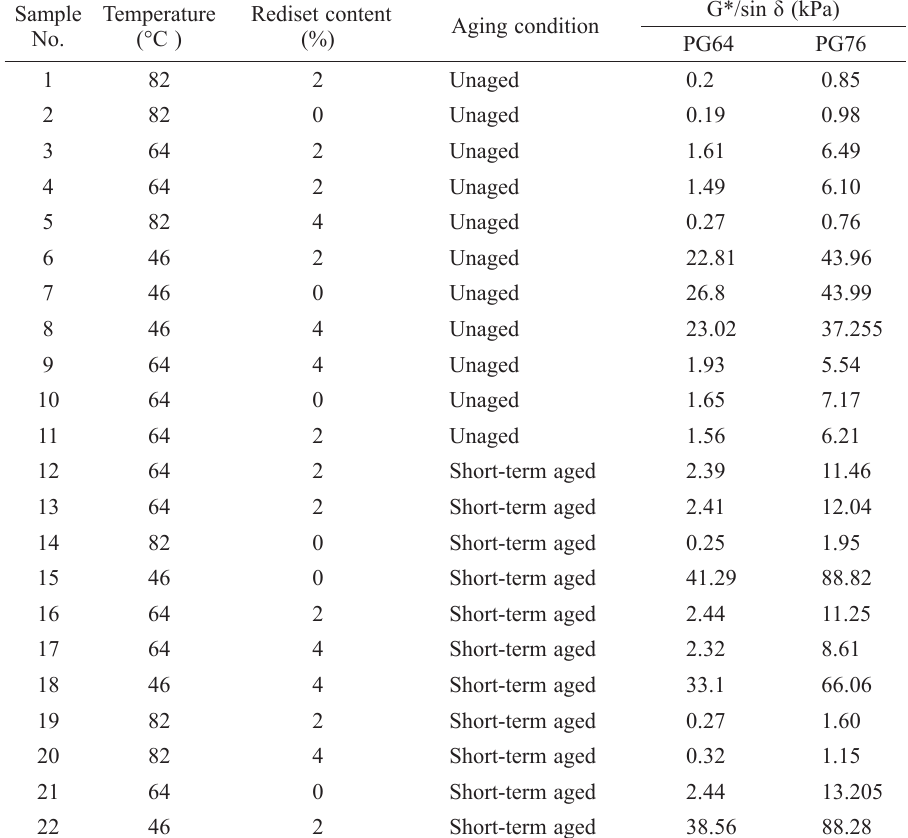
Table 4. Experiment matrix for G/sin δ Sample No.